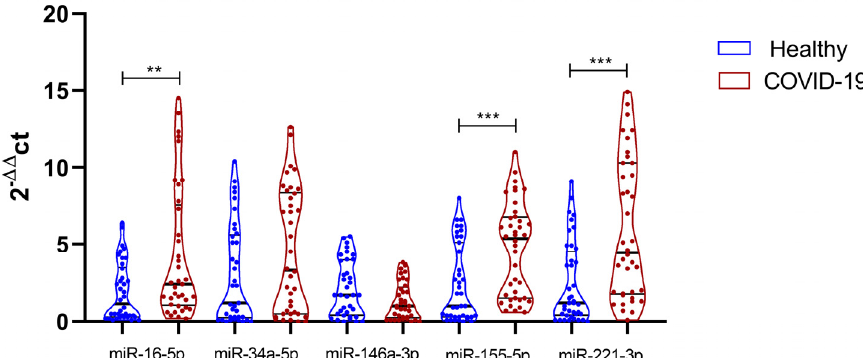
Figure 2. Violin plot shows the relative expression of miRNAs in COVID-19 patient vs. healthy controls. The violins represent medians and interquartile ranges. Data were analyzed using the Kruskal–Wallis test and Dunn’s post hoc test when significant values were obtained (** and *** p < 0.05).